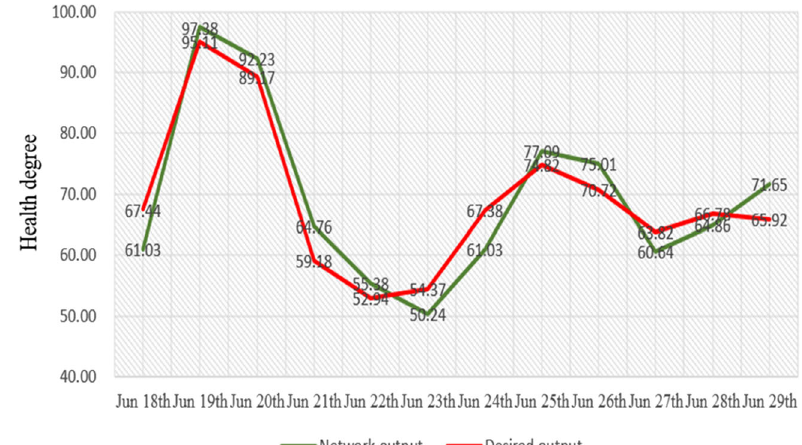
Fig. 8 Comparing the results of neural network models and the desired output